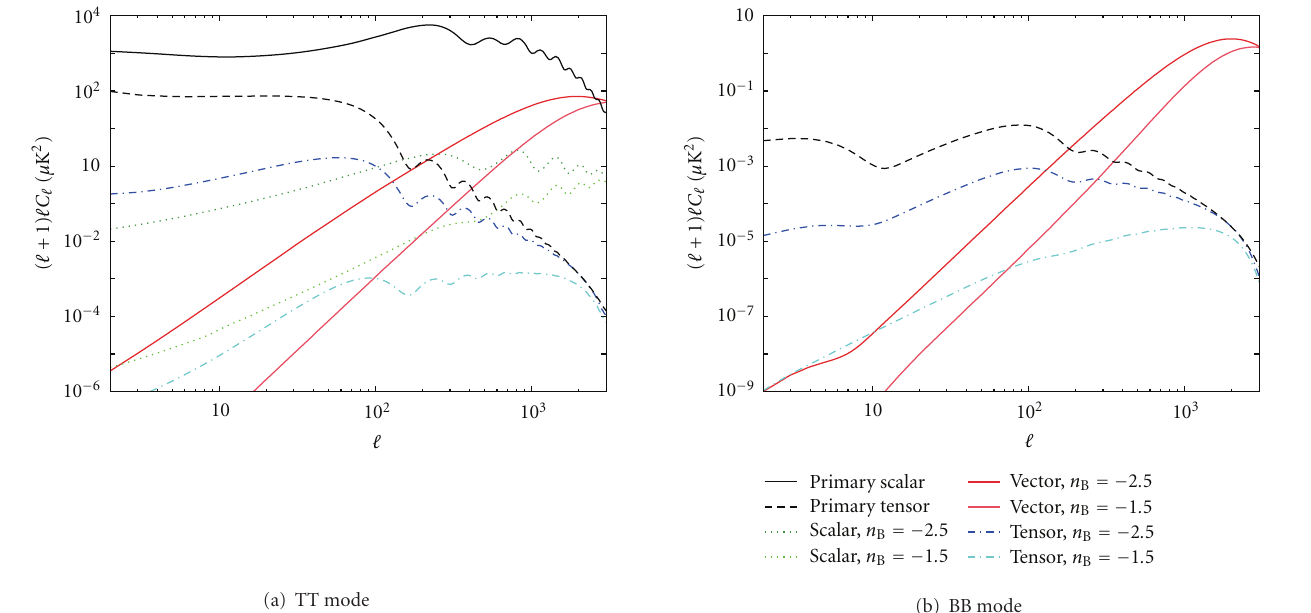
Figure 4: Polarization anisotropies and temperature fluctuations of the CMB in the from a PMF. (a) and (b) show the TT and BB modes, respectively, for models with B λ = 3 . 0 nG and n B = − 1 . 5 or − 2.5 as labeled. We use a scalar to tensor ratio of 0.2 for the primary tensor.